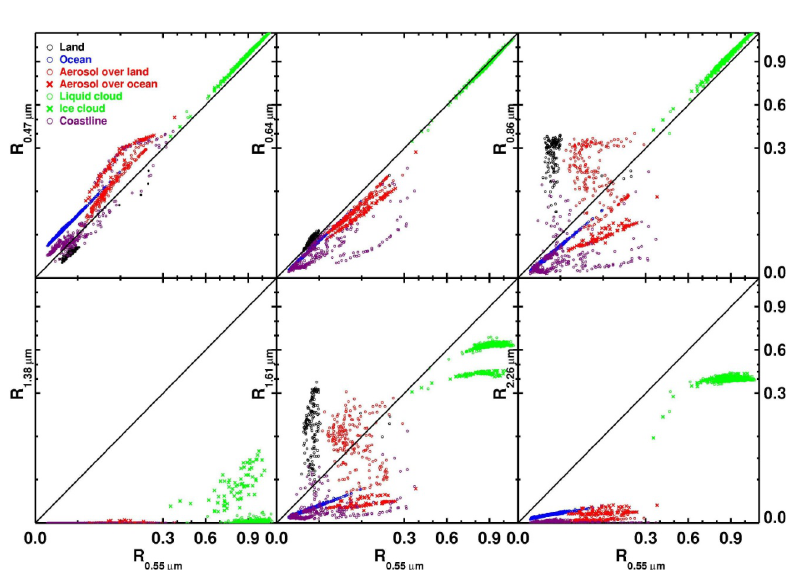
Figure 5c Fig. 5c. Same as in Fig. 6a, but on 25 March